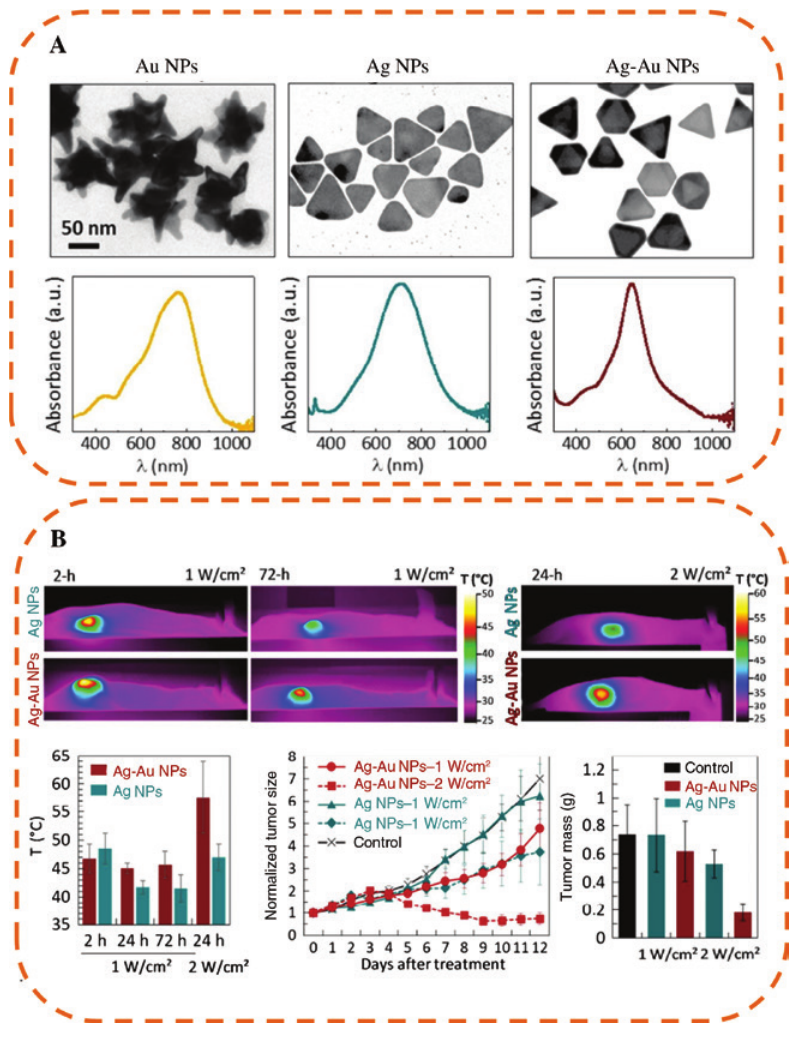
Figure 8: Structure and photothermal efficiency of Ag, Au, and Ag–Au NPs. (A) Transmission electron microscopy (TEM) images and UV-visible/NIR spectra of Au NPs, Ag NPs, and Ag–Au NPs. (B) Infrared (IR) thermal images of mice injected with Ag NPs and Ag–Au NPs exposed under NIR-laser irradiation (680 nm, 1 min, 1 W cm −2 ) with corresponding analysis of average temperature after 1 min of 680 nm NIR-laser exposure and effect on tumours. Reprinted with permission from [116]. Copyright 2018 American Chemical